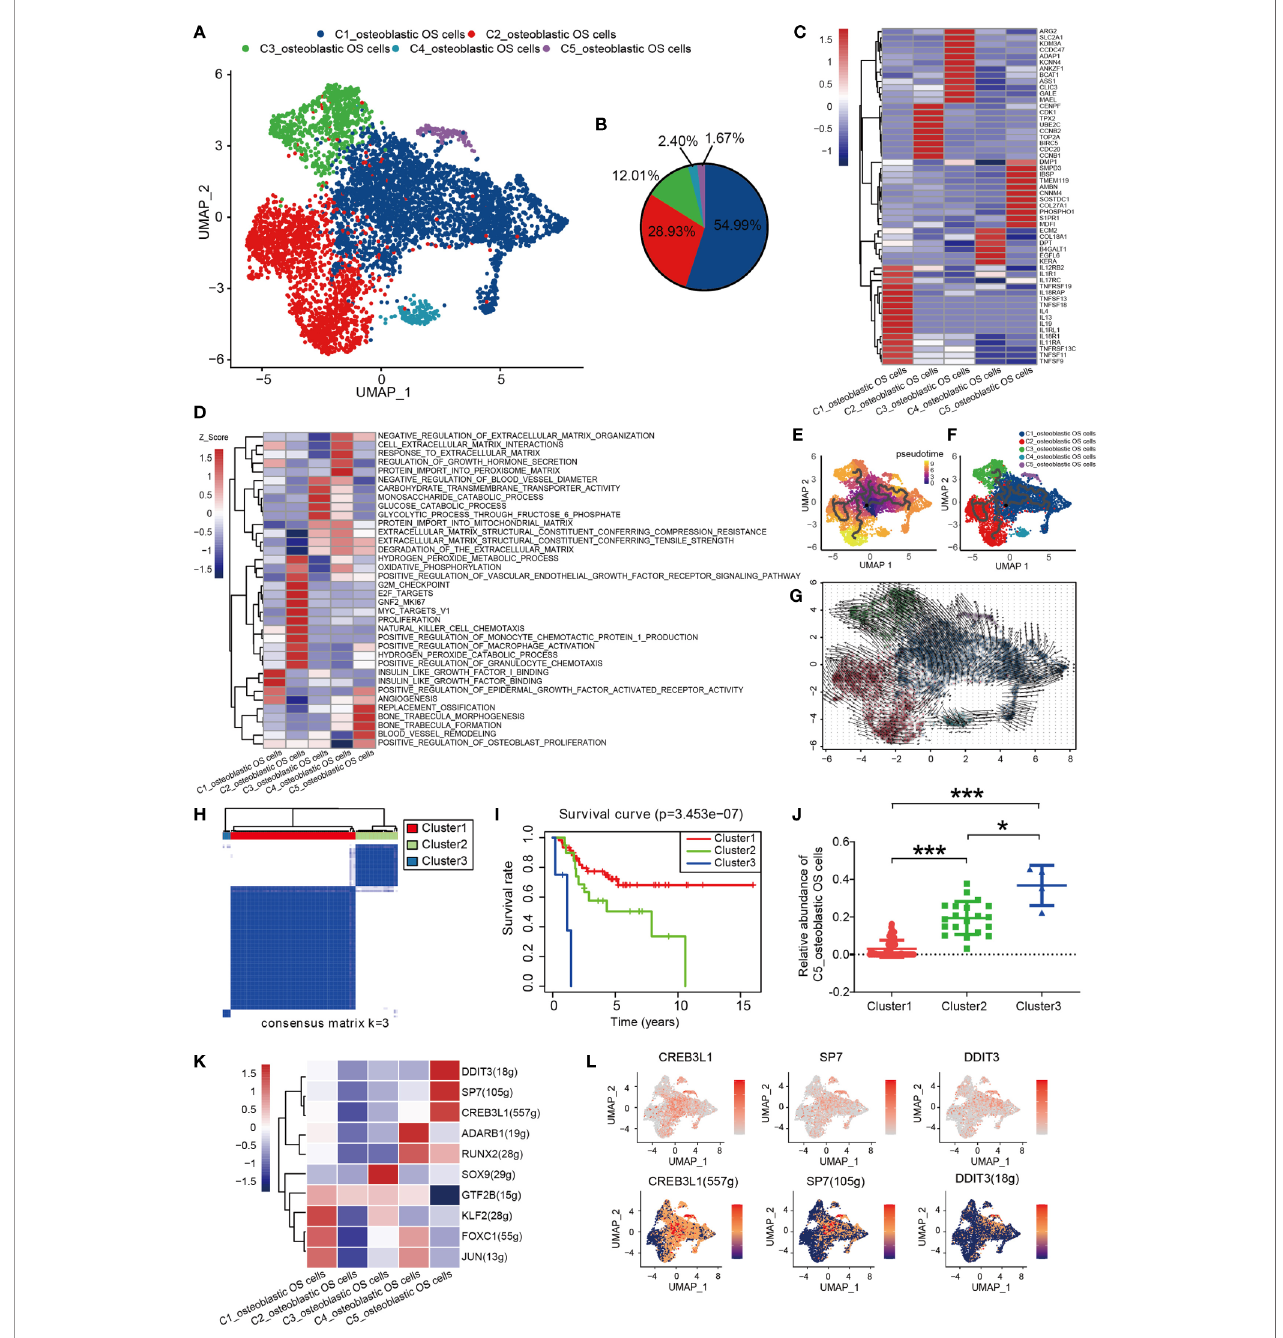
FIGURE 2 | Heterogeneity of osteoblastic OS cell populations in OS. (A) UMAP plot showing osteoblastic OS cells. Different cell types are represented by the different colors. (B) Pie chart, indicating the cell composition of osteoblastic OS cells. (C) Heat map showing the marker genes of each cluster, with the selected osteoblastic OS cell marker genes in each cluster highlighted. (D) GSVA, showing the function of different types of osteoblastic OS cells. (E, F) Differentiation and developmental trajectories of osteoblastic OS cells in OS. (G) RNA velocity fi eld projected onto the UMAP plot of the osteoblastic OS cells; the arrows indicate the direction of differentiation and the average velocity. (H) OS patients in the TARGET OS cohort were clustered into 3 clusters by ConsensusClusterPlus, based on cell clusters identi fi ed in this pro fi le. (I) Kaplan-Meier survival curve of 3 patient clusters. (J) Relative abundance of C5_osteoblastic OS cell Clusters 1 (left), 2 (middle) and 3 (right). (K) Heatmap of the AUC scores of expression regulation by transcription factors estimated by SCENIC. (L) UMAP plot of osteoblastic OS cells, color-coded for the expression level (up) and for the AUC of the estimated regulon activity of these transcription factors (down). *P < 0.05,***P < 0.001; OS, osteosarcoma; UMAP, uniform manifold approximation and projection; GSVA, gene set variation analysis; SCENIC, single-cell regulatory network inference and clustering; AUC, area under the